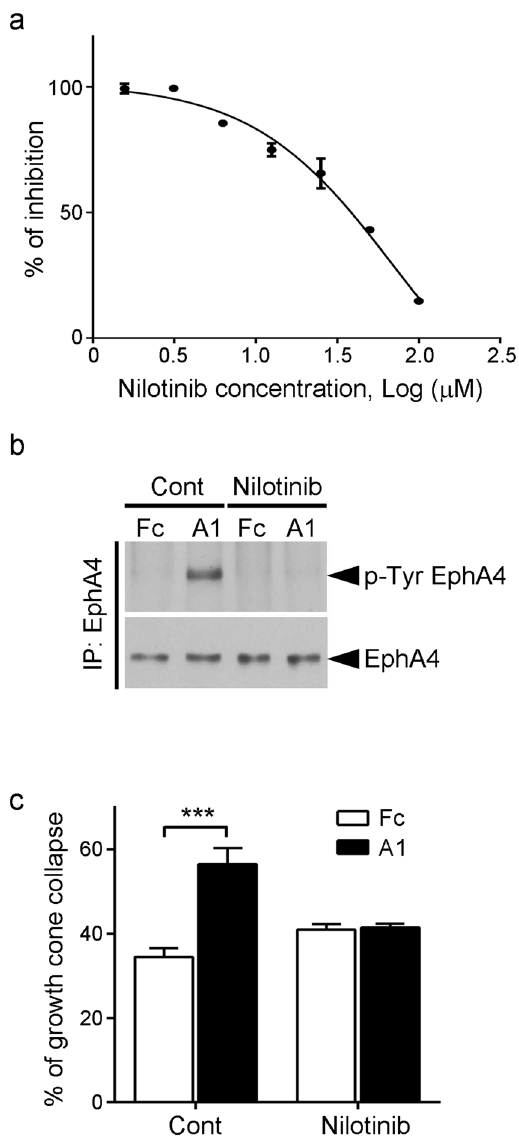
Figure 2. Nilotinib inhibits ephrin-A and EphA4 interaction, and EphA4-dependent signaling and cellular functions. ( a ) Dose–response curve of the inhibitory activity of nilotinib against the interaction of mouse EphA4 with ephrin-A1. ( b ) Nilotinib attenuated the ephrin-A1 (A1)-induced EphA4 tyrosine phosphorylation in rat hippocampal neurons. Lysate was immunoprecipitated with EphA4 antibody and subjected to western blot analysis for P-Tyr. ( c ) Nilotinib inhibited ephrin-A1–stimulated growth cone collapse in cultured hippocampal neurons (mean ± SEM, ≥ 75 neurons for each group from 3 experiments). *** p < 0.001; two-way ANOVA followed by the Bonferroni post hoc test. Cont (ephrin-A1–treated neurons